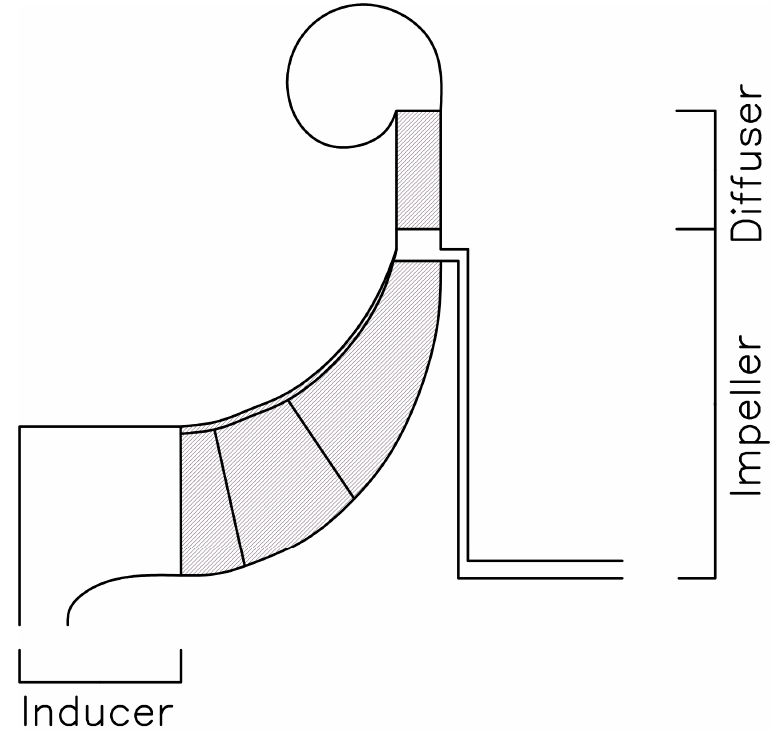
Figure 3. Meridional view of a centrifugal compressor stage.